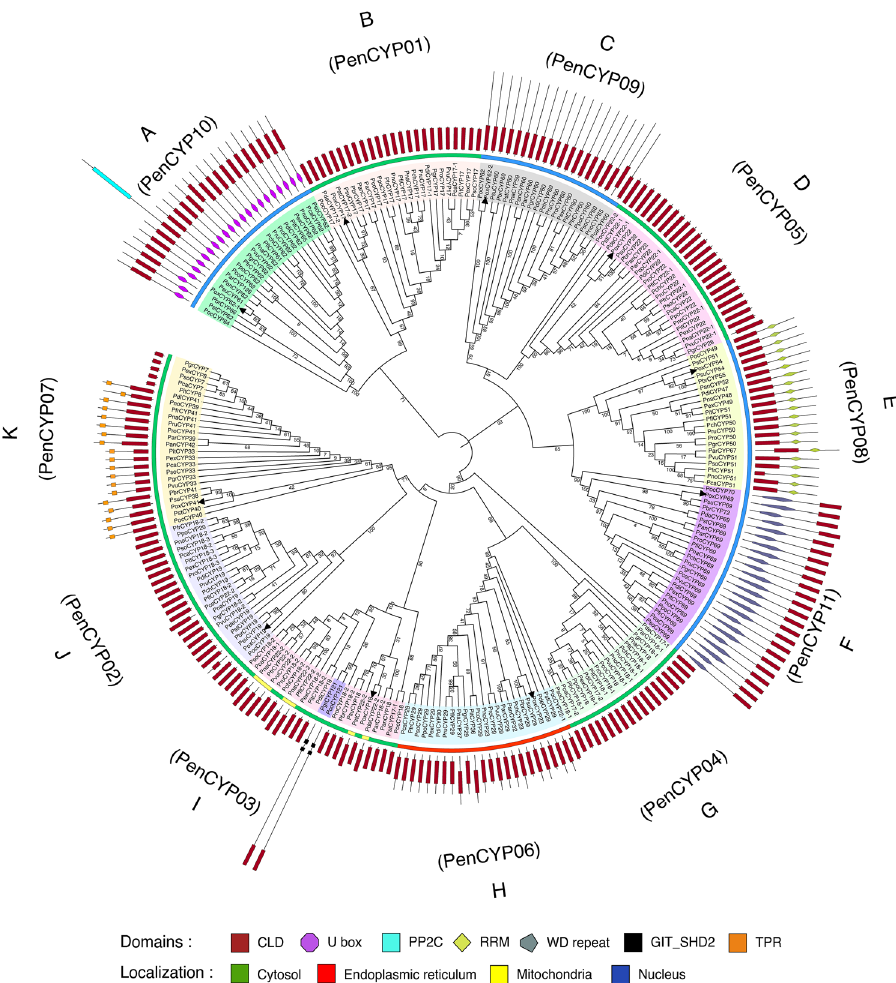
Figure 2. The phylogenetic relationship of different Penicillium cyclophilins. The unrooted tree was generated using the neighbor-joining method in MEGA X (v10.1.7) software (http:// www. megas oftwa re. net). The constructed tree was further annotated with the Iterative Tree of Life (http:// itol. embl. de/) and redrawn in Adobe Illustrator (v25.2.3) (https:// adobe. com/ produ cts/ illus trator). Bootstrap values from 1000 replicates are indicated at each branch. The localization of each member is represented in different colors. Domain architecture of each protein is also shown in the outermost layer. Black triangles represent the Penicillium oxalicum